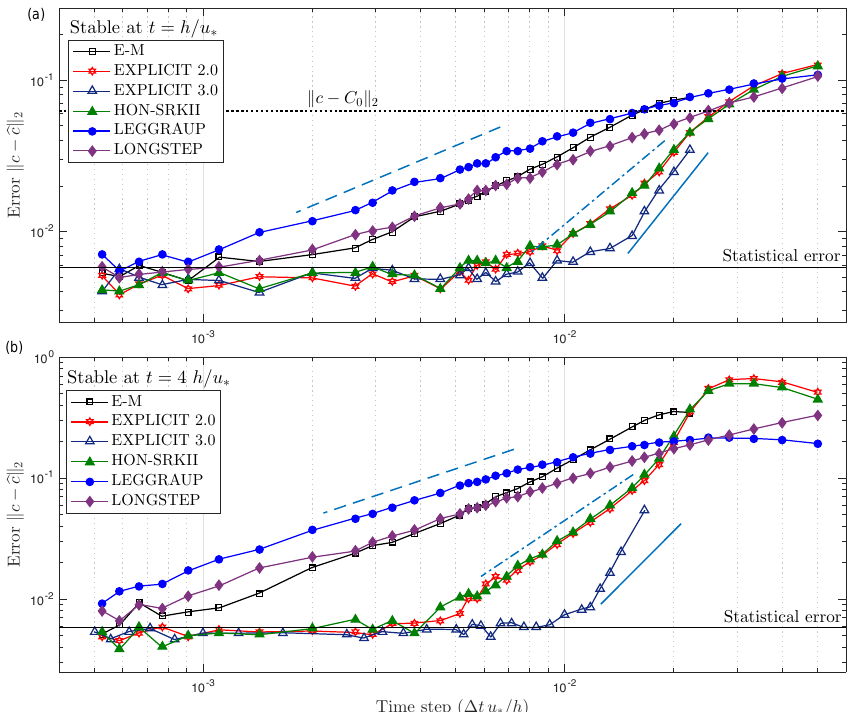
Figure 5. L 2 error (Eq. 20) as a function of non-dimensional time step (cid:49)t u ∗ /h for the stable ABL test case integrated at intermediate time t = h/u ∗ (a) and at late time t = 4 h/u ∗ (b) . From left to right, blue lines of slopes 1 , 2, and 3 are plotted for reference.